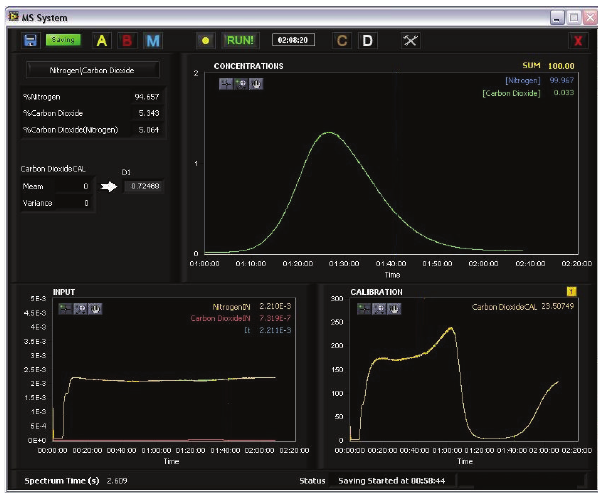
Figure 3: Illustration of the graphical interface of the algorithm developed.